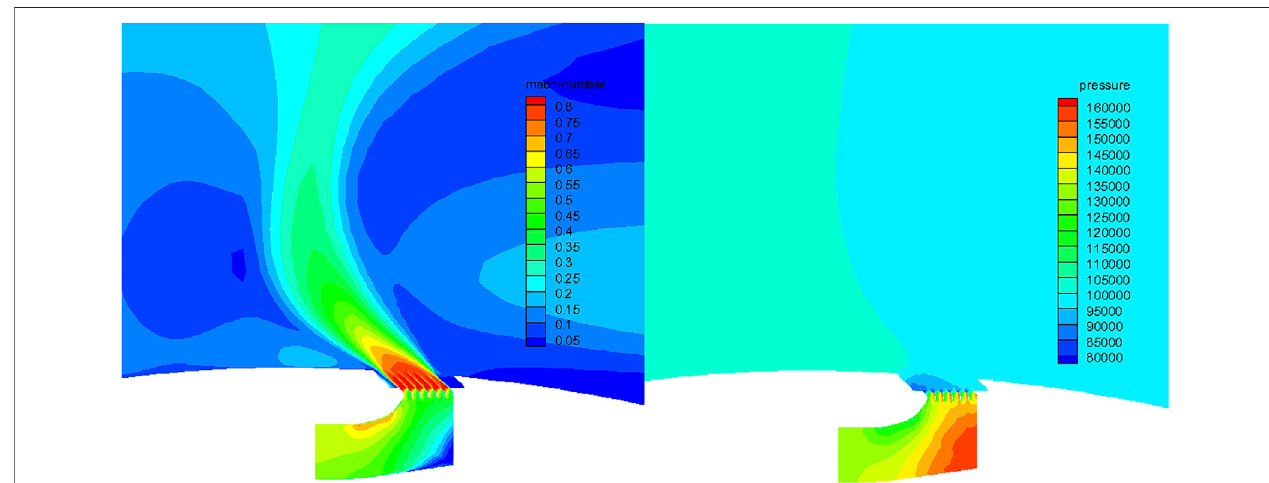
FIGURE 11 | Mach number distribution and static pressure distribution of optimal individual of equal thickness blade.